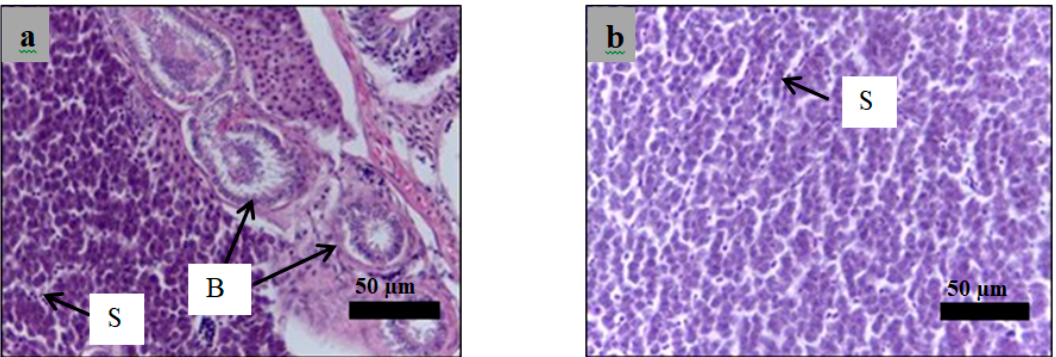
Figure 16. Paraffin section of zebrafish liver analyzed using hematoxylin and eosin staining for the plant extract treated zebrafish (( a , b ): 40 × magnification). The hepatocytes show normal structure comparing to control. B: bile ductules, S: sinusoidal spaces.